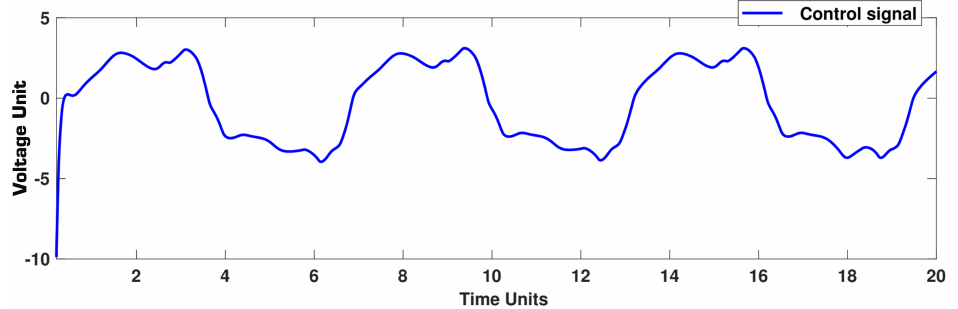
Figure 5. Example 1: Control